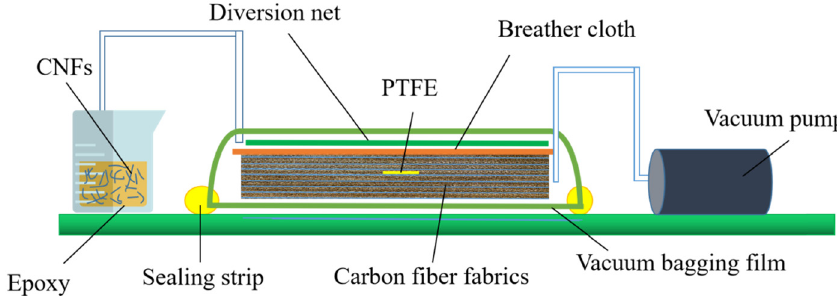
Figure 3: Schematic diagram of the production process.